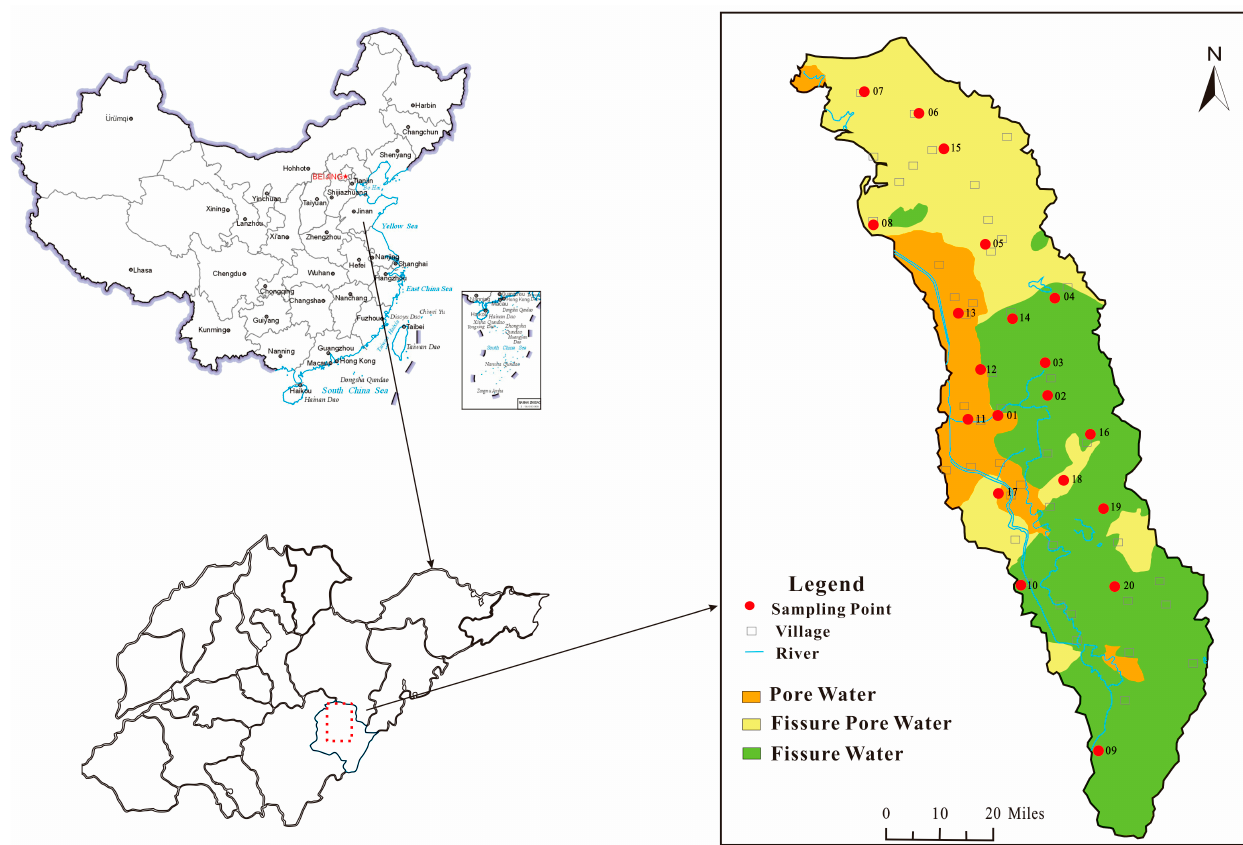
Figure 1. Geographical locations of the study area and sampling sites for three different types of groundwater.